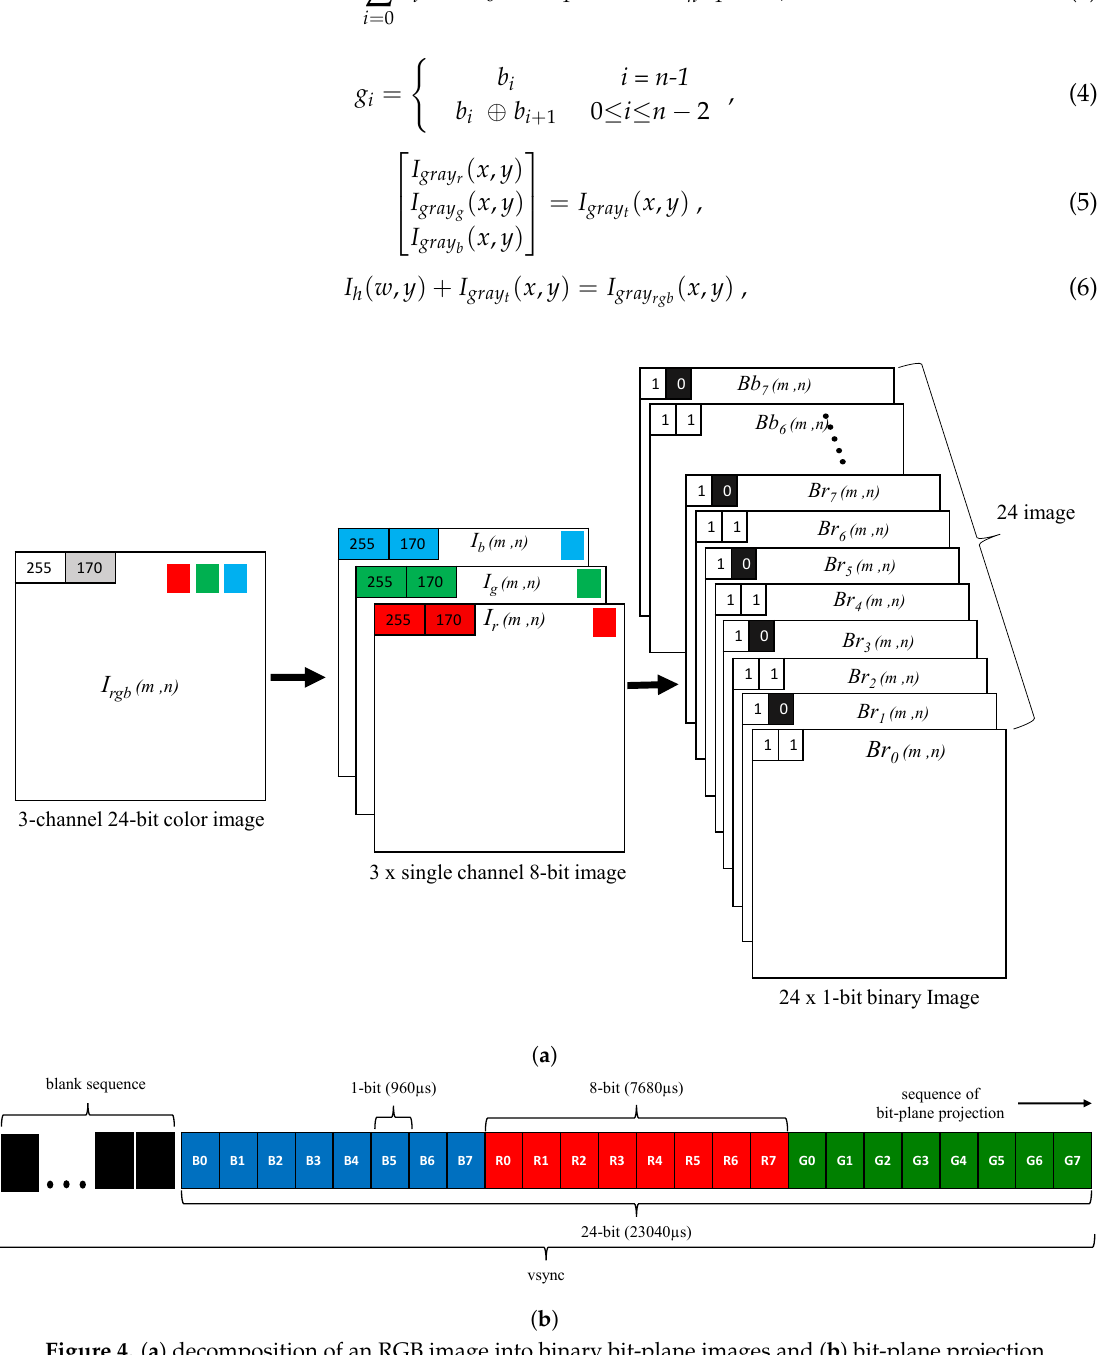
Figure 4. ( a ) decomposition of an RGB image into binary bit-plane images and ( b ) bit-plane projection pattern for a single RGB